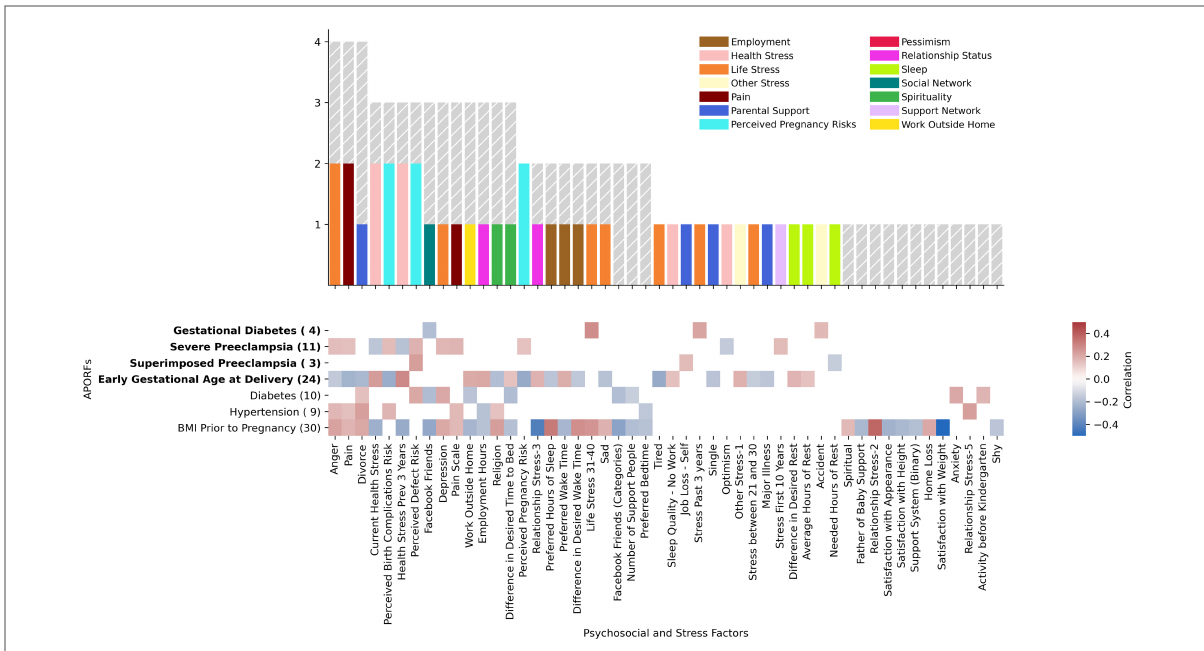
FIGURE 5 Number of APORFs signi fi cantly correlated with individual stress factors. The bar plot depicts PSFs, colored by cluster (cf. Supplementary Figure S4 ). Height of the bars represents the number of APORFs for which the PSF was signi fi cantly associated with APOs (colored bars) and RFs (gray bars). Hours of rest, why women thought they may experience birth defects ( “ perceived reason for defect ” ), and pain were correlated with the largest number of APORFs. The heatmap depicts Spearman correlation of PSFs with APORFs. Grey heatmap squares represent correlations of PSFs with APORFs that were not signi fi cant (signi fi cance was denoted by p